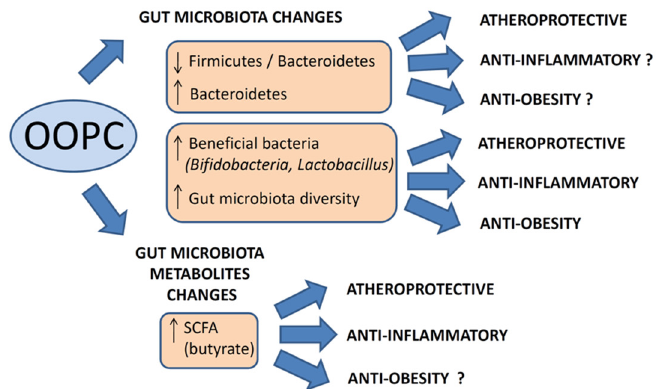
Table S1: Results from PREDIMED study on lipid metabolism, immune system, and